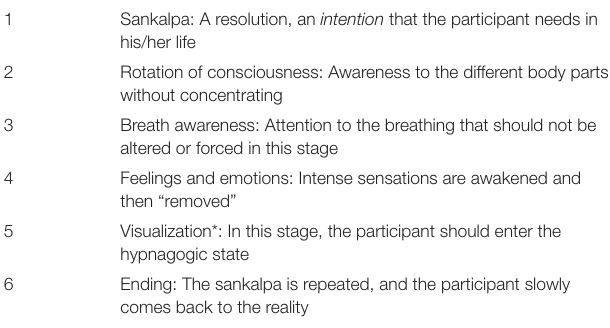
TABLE 1 | The different stages of Yoga